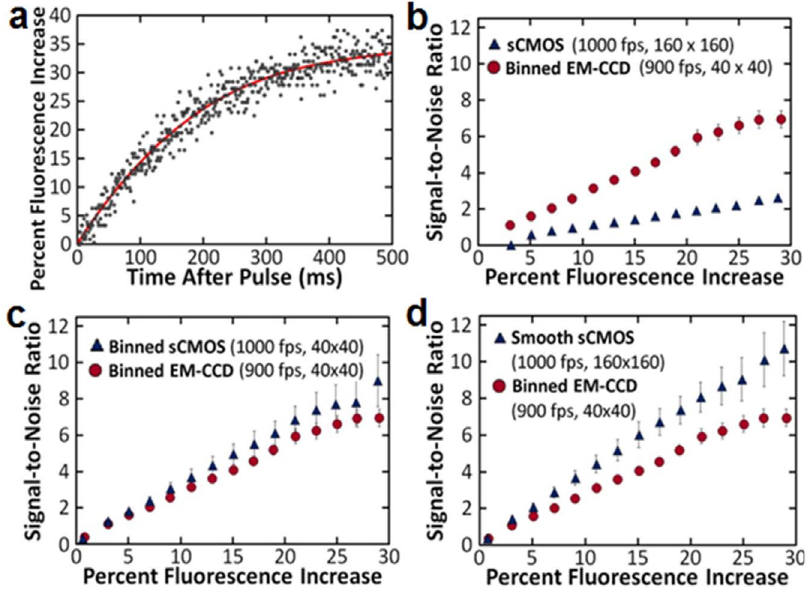
Figure 3. Signal-to-noise comparison between the EM-CCD and CMOS cameras. a) A representative plot showing the measured fluorescence increase at each time-point and polynomial fit for an individual pixel. b) SNR comparison of the raw EM-CCD and sCMOS images with similar acquisition rates. c) SNR comparison with the sCMOS images binned to achieve similar resolution as the EM-CCD. d) SNR comparison with Gaussian smoothing applied to the sCMOS image.